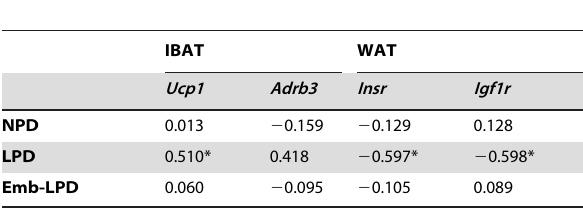
Table 11. Correlations (r values) of serum glucose levels with relative real-time RT-PCR expression values from interscapular brown adipose tissue (IBAT) and retroperitoneal white adipose tissue